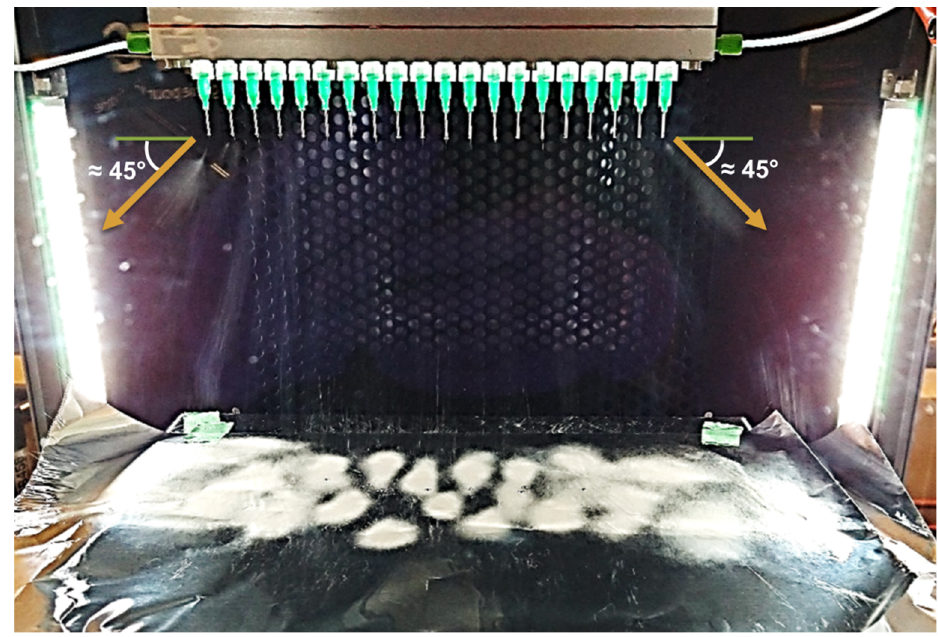
Figure 1. Multi-needle electrospinning, initial setup (without auxiliary electrodes).